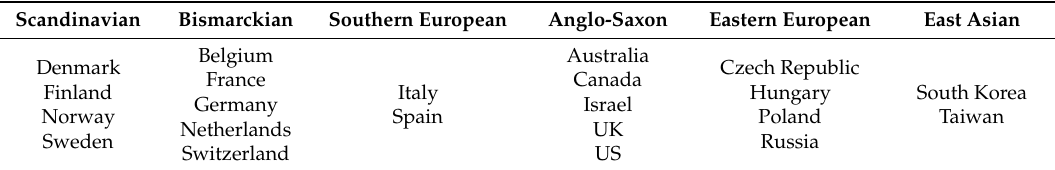
Table A1. Classification of Countries by Type of Welfare Regime.